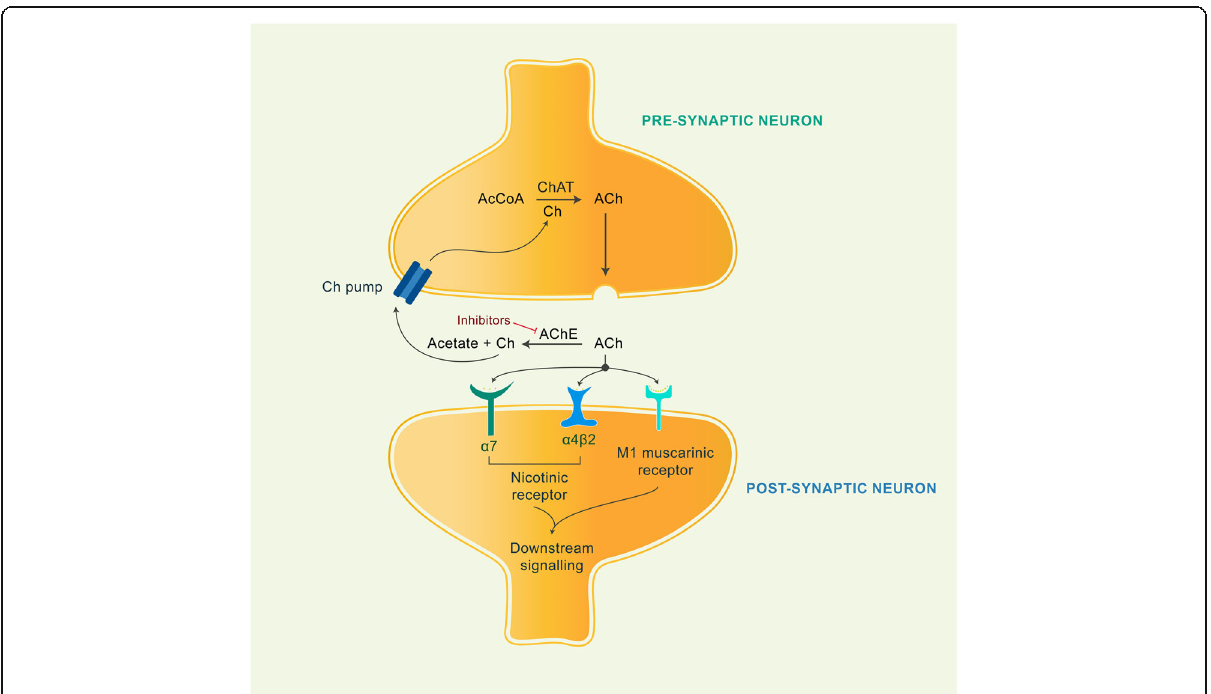
Fig. 1 Cholinergic hypothesis and role of AChE in AD development. ACh is synthesized by ChAT and released from the pre-synaptic neuron. The ACh mediates its effects on the post-synaptic neuron through nicotinic and/or muscarinic receptors. The ACh then performs the downstream signaling in the post-synaptic neuron. AChE enzyme breaks down the ACh and overexpression of AChE lowers the amount of ACh in the brain which leads to the AD onset. AChE inhibitors repress the AChE activity, thus aid in the AD